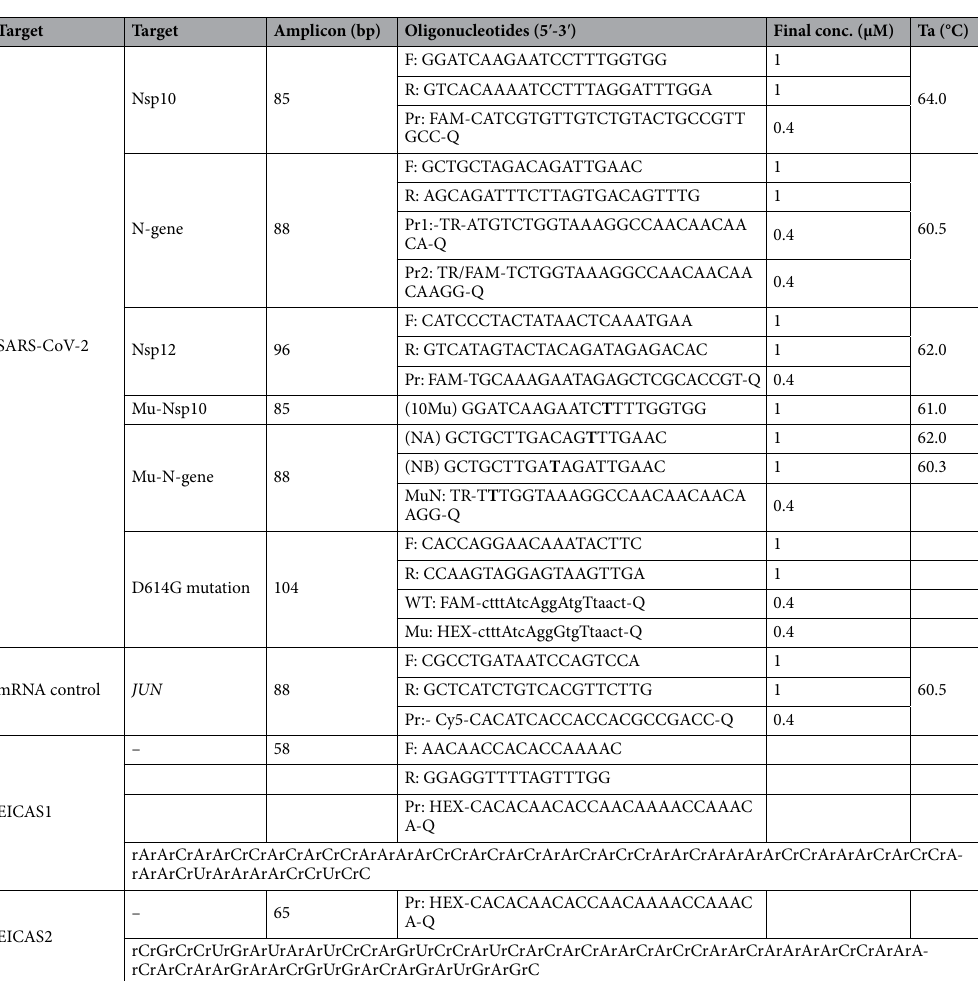
Table 2. Details of oligonucleotide sequences, fluorophores, optimal concentrations and annealing temperatures used for the detection of SARS-CoV-2 targeting Nsp10, N-gene, Nsp12, JUN and EICAS, collectively referred to as CoV2-ID. All oligonucleotides are listed in the 5 ′ -3 ′ direction. Nucleotides that differ from the SARS-CoV-2 reference sequence, but have been detected at low frequency are shown in red. Oligonucleotides are based on the following accession numbers: Reference SARS-CoV-2: NC_045512;